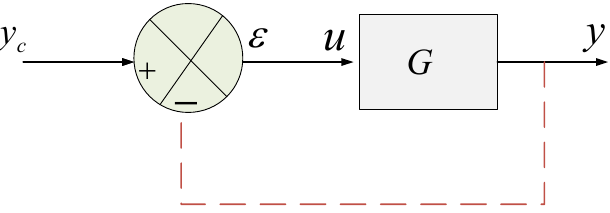
Figure 3. Control-loop-based SFCL control.